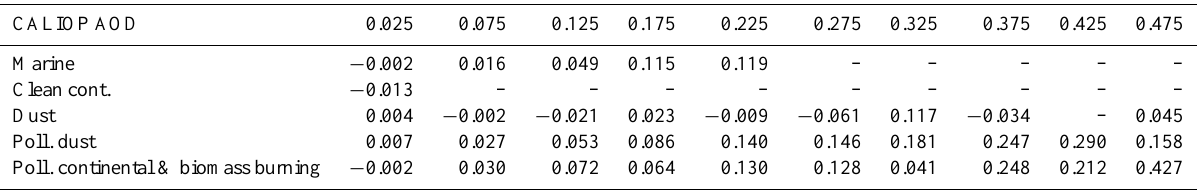
Table 5. Median AOD layer bias (CALIOP – HSRL) for each CALIOP aerosol type as a function CALIOP AOD (Daytime, bin width of 0.05).